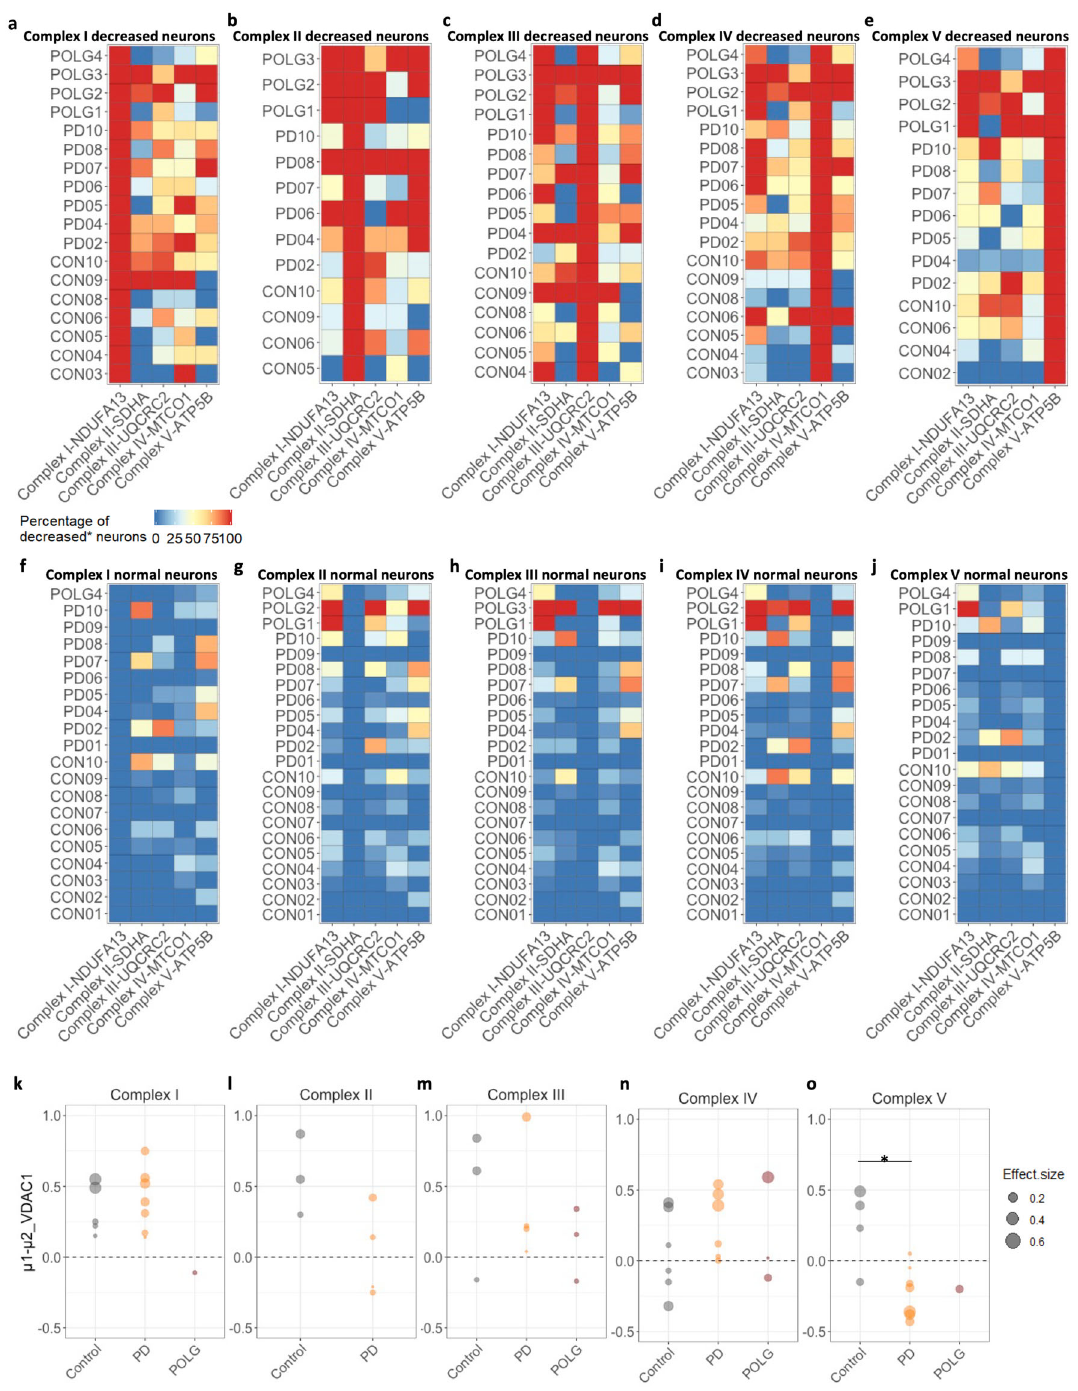
Fig. 6 Complexity of OxPhos de fi ciencies within Substantia nigra neurons. a – e Heatmaps to illustrate the percentage of neurons which show a decreased level of protein expression within each individual complex among the fi ve categories of de fi cient neuronal populations (complex I – V de fi cient neurons respectively). f – j These are shown alongside the same percentage calculations within the corresponding normal neuronal populations. Cases with no de fi cient neurons were excluded from this analysis. k – o Using Bayesian estimation, the difference of means ( µ1 – µ2 ; µ1 -decreased, µ2 -normal) of mitochondrial mass (VDAC1) between the decreased and normal neurons of each individual case was analysed and compared between groups. Only cases with three or more neurons which fell into each category were included. Group